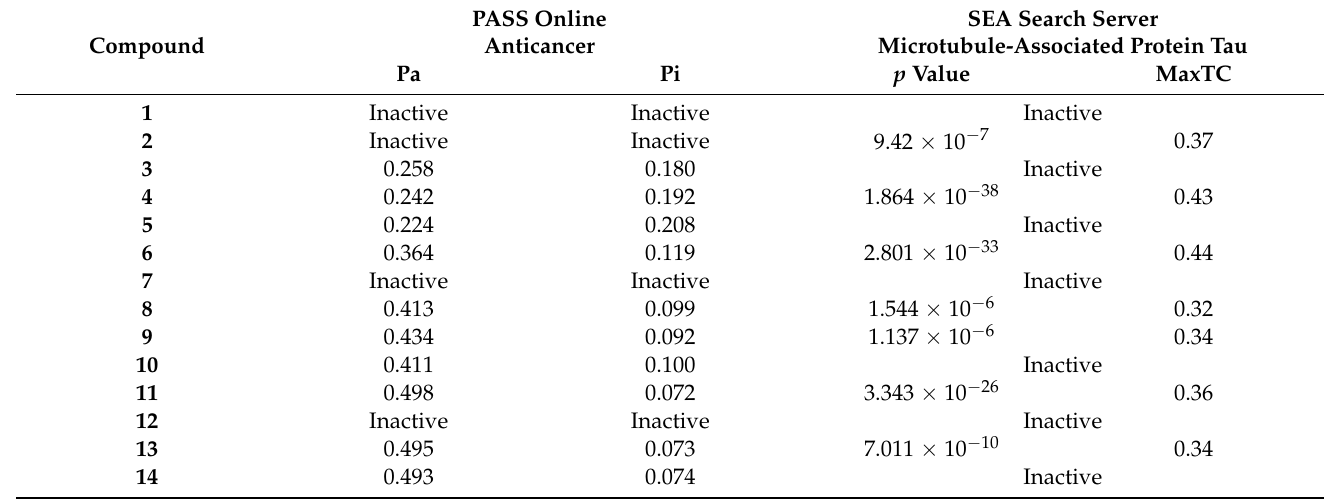
Table 3. Anticancer activity and molecular target predictions obtained using the PASS Online and SEA Search webservers.